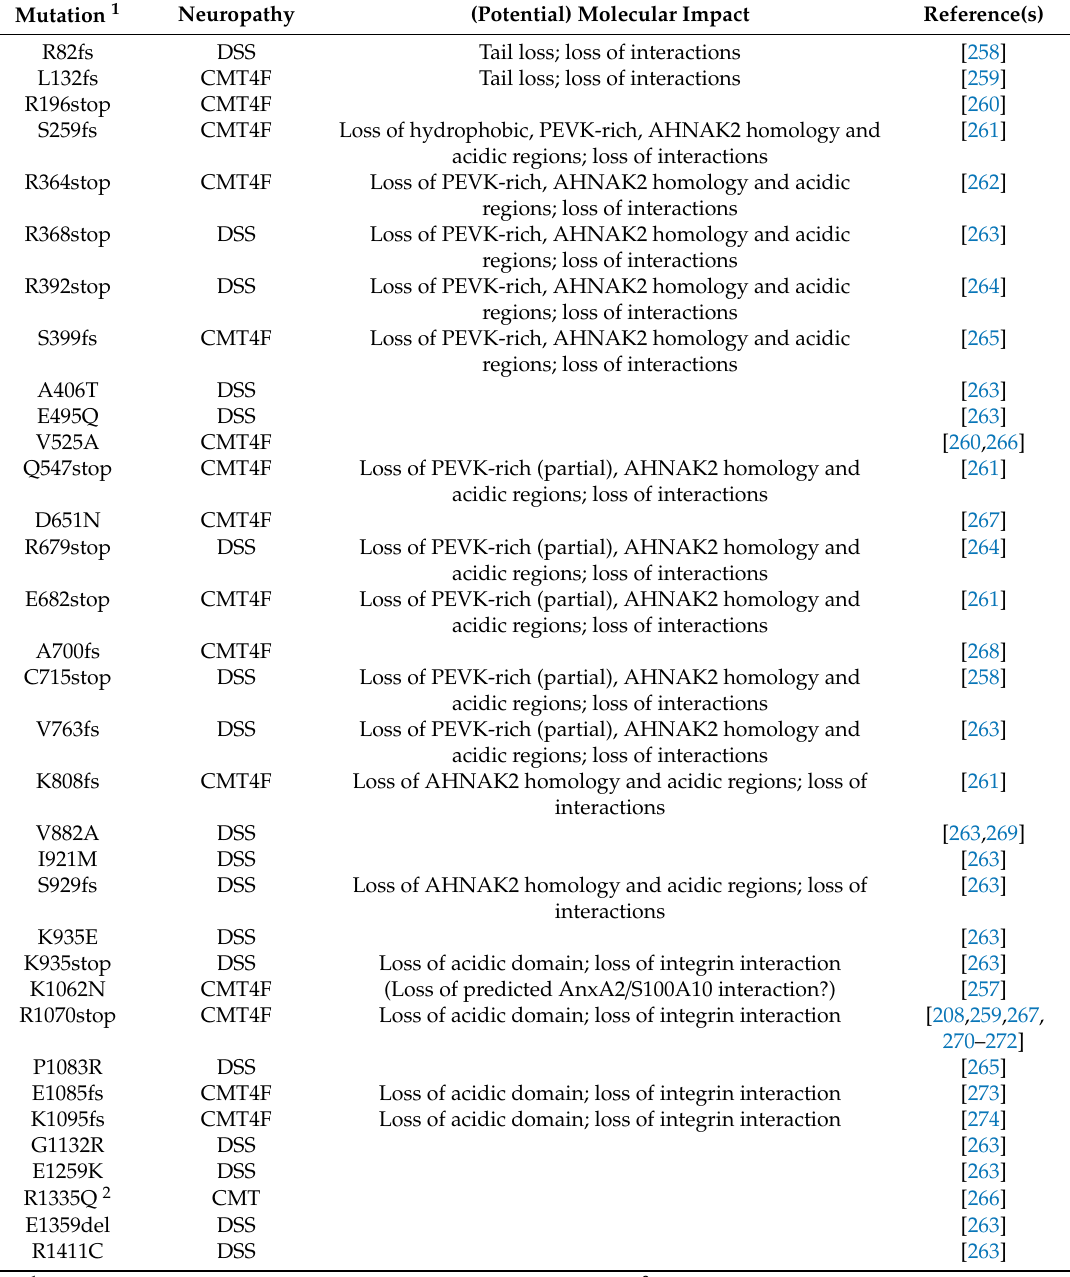
Table 1. PRX mutations, related neuropathies and potential molecular